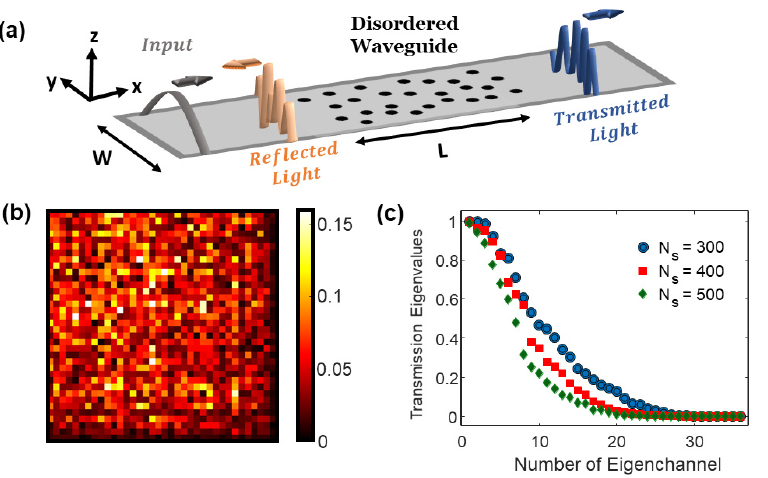
Figure 1. Schematic of the device and numerical simulations. ( a ) Schematic of the disordered waveguide studied in this paper. The grey region corresponds to the silicon waveguide and black circles correspond to air holes; ( b ) Absolute value of a transmission matrix calculated for a single random configuration with N s = 300; ( c ) Transmission eigenvalues of disordered waveguides with three different scattering strengths ( N s = 300, 400, and 500 respectively). As N s increases, due to enhanced backscattering, the values of the transmission eigenvalues decrease.